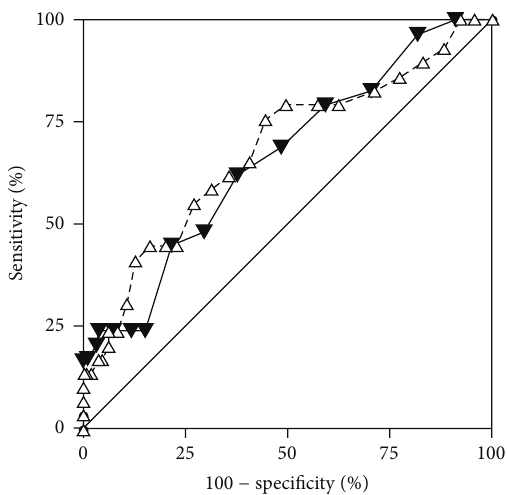
Figure 3: Comparative receiver operating characteristic (ROC) curves for HADS-depression (solid triangles) and HADS-total (white